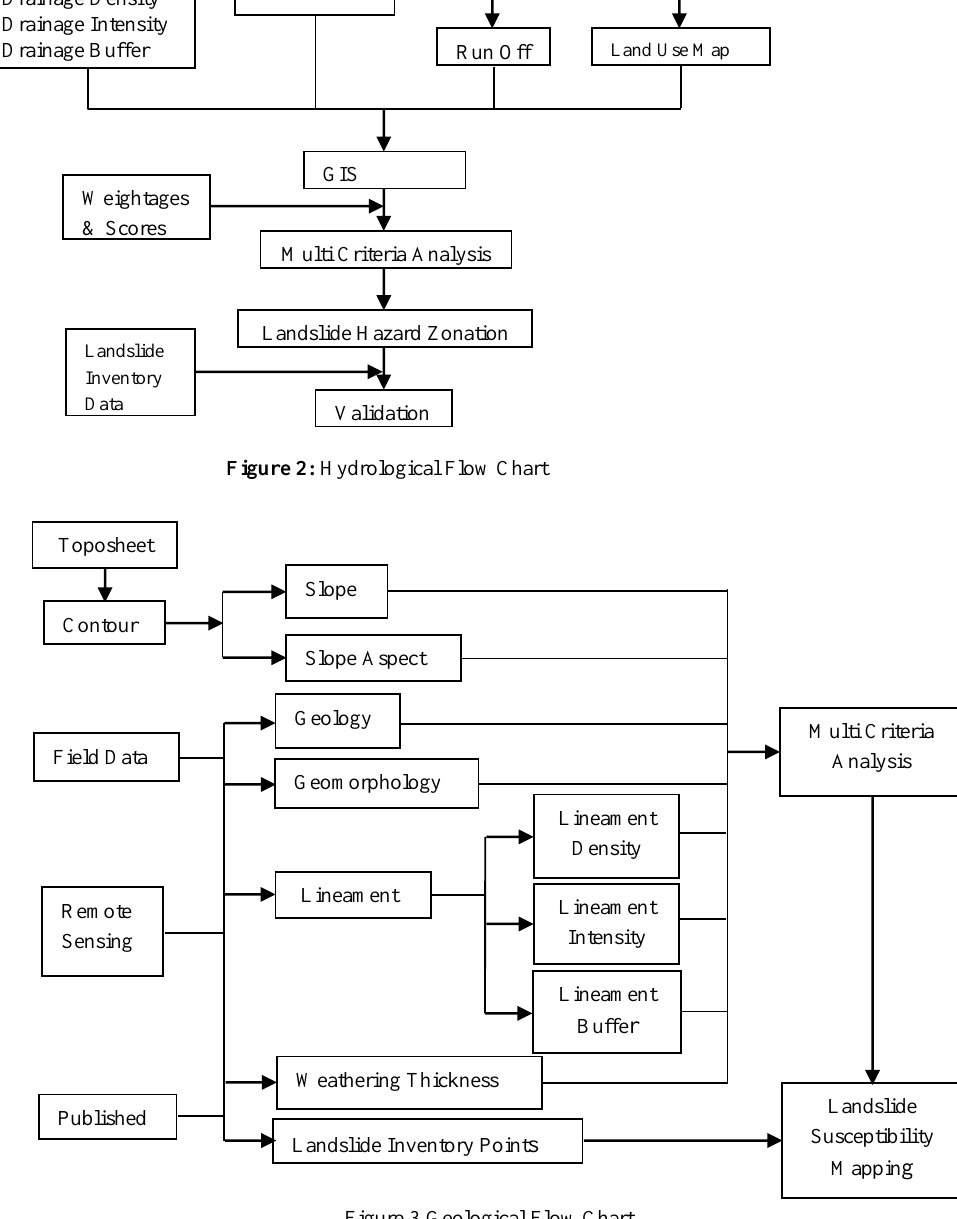
Figure 3 Geological Flow Chart